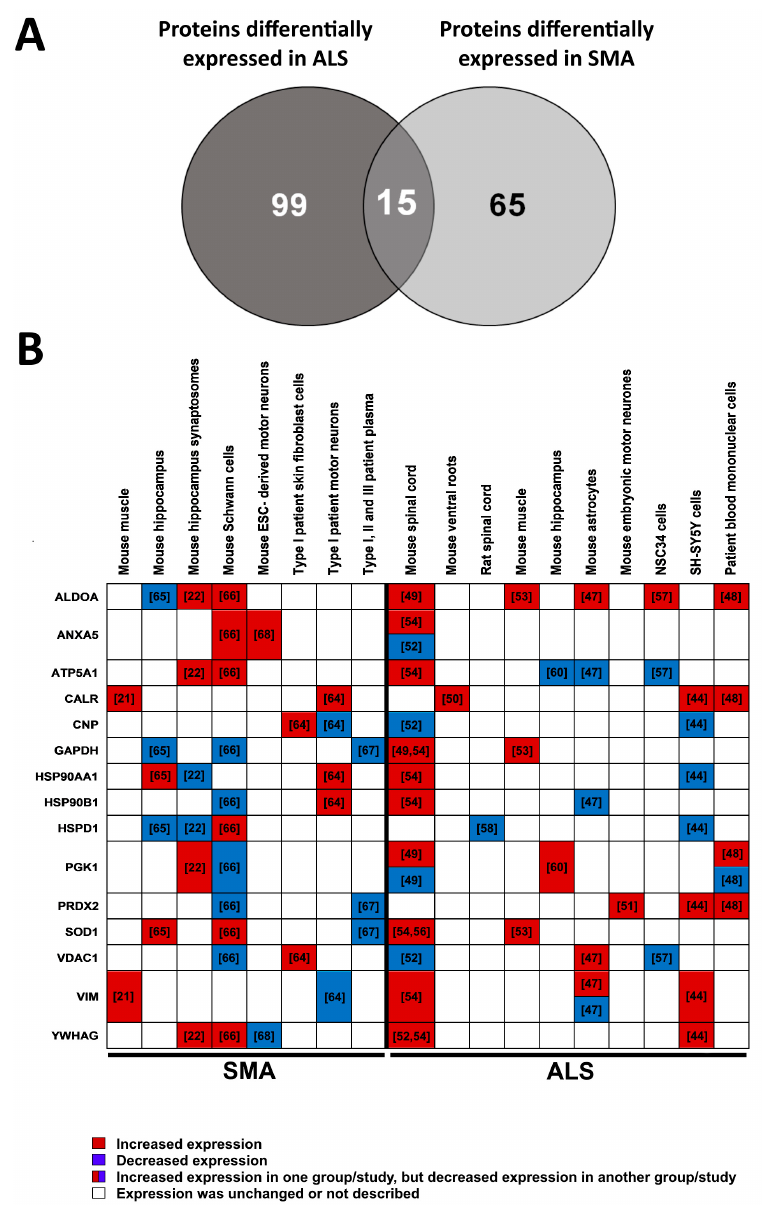
Figure 2. Proteins differentially expressed in both spinal muscular atrophy (SMA) and ALS proteomic studies. ( A ) Venn diagram showing the number of proteins differentially expressed in SMA proteomic studies compared to ALS proteomic studies. Fifteen of those proteins were identified in both SMA and ALS comparison. ( B ) Heat map of proteins that were differentially expressed in both SMA and ALS proteomic studies. Protein names are presented as official gene symbols. The reference for each study is given in the corresponding squares of the heat map. Experimental model and sample type used in each study are indicated above the table. ALDOA—Aldolase,